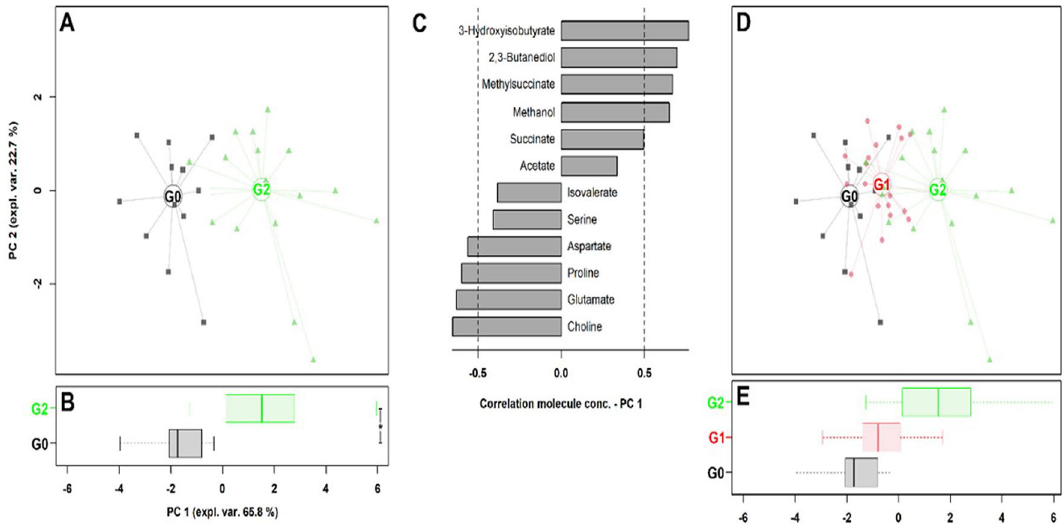
Figure 1. rPCA model built on the space constituted by the concentration of the significant metabolites listed in Table 2 for Groups G0 and G2. In the scoreplot (A) , samples from Groups G0 and G2 are represented with black squares and green triangles, respectively. The wide, empty circles represent the median of each sample group. The position of the samples along PC1 is summarized in the boxplot (B) . The loading plot (C) reports the significant correlation between the concentration of each substance and its importance over PC 1 ( p < 0.05). The G1 group is represented as red circles in scoreplot (D) and boxplot (E) .